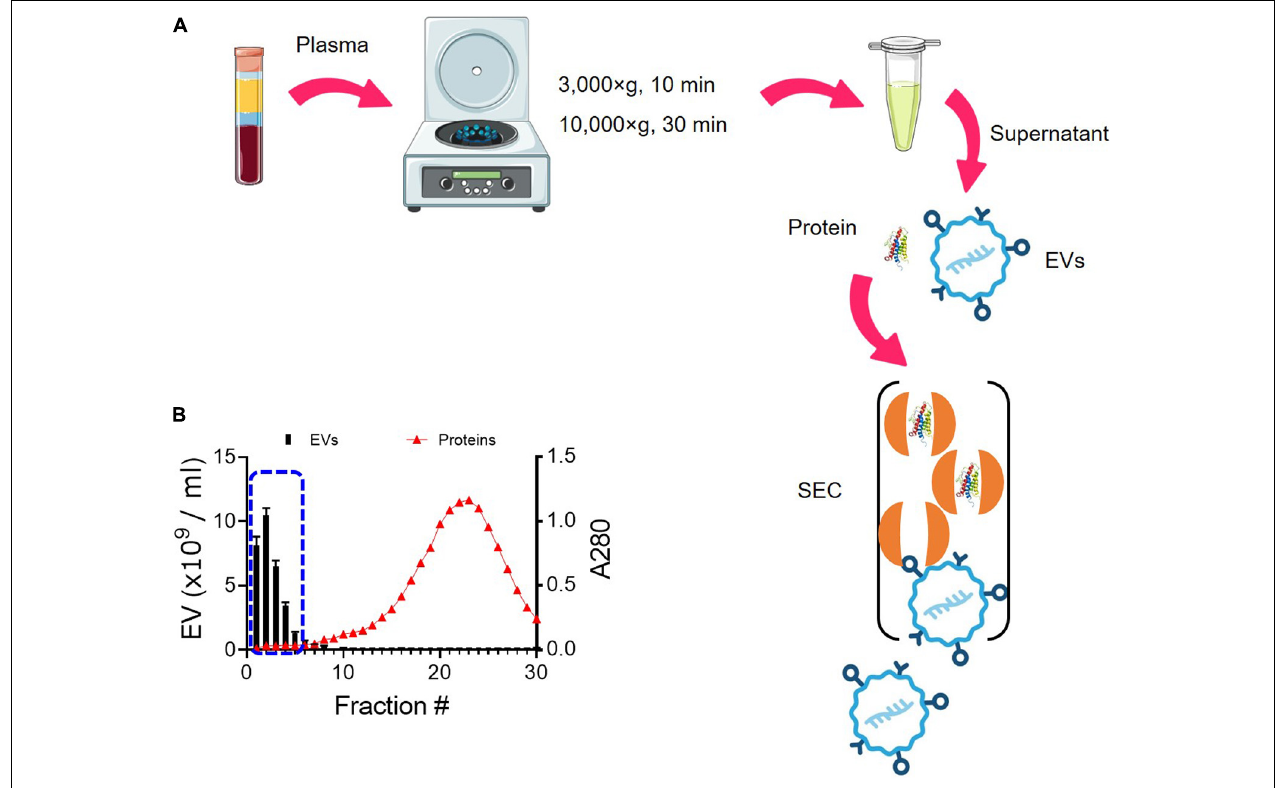
FIGURE 1 | Enrichment of EVs from plasma using SEC. (A) Schematic overview of the procedure for isolating EVs from plasma using SEC. EVs elute first, followed by smaller protein complexes. (B) Elution profiles of EVs and plasma protein. EV particle numbers and protein concentration in each fraction from 1 to 30 were determined by NTA and the absorbance at a wavelength of 280 nm, respectively. Fractions 1–5 were subsequently pooled together as EV samples (blue dotted